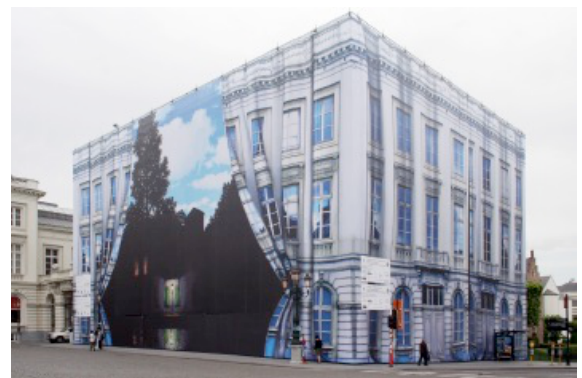
Figure 6 . Cover sheet placed over the Magritte Museum (https://www.regiedergebouwen.be/nl/projects/magritte- museum).